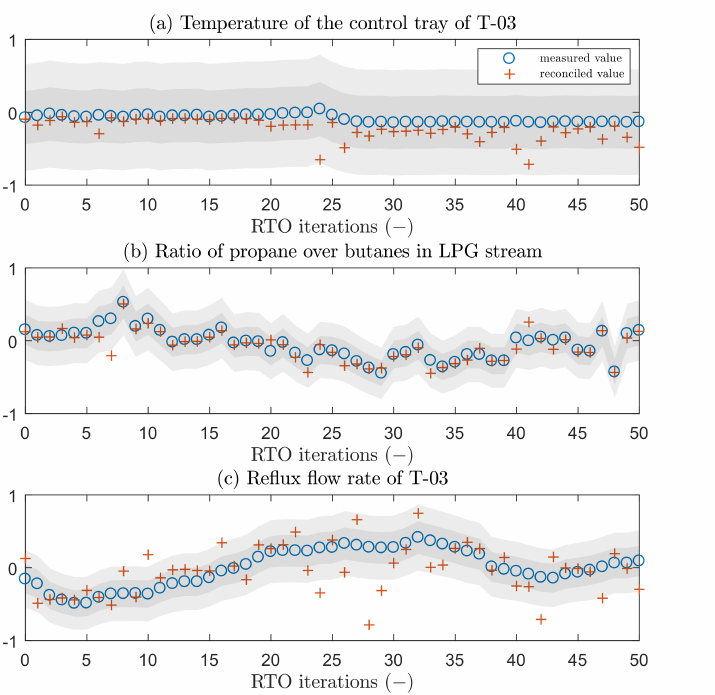
Figure 7. Data reconciliation results: ( a ) temperature of the control tray of T-03; ( b ) ratio of the content of propane over butanes in LPG; ( c ) Reflux flow rate of